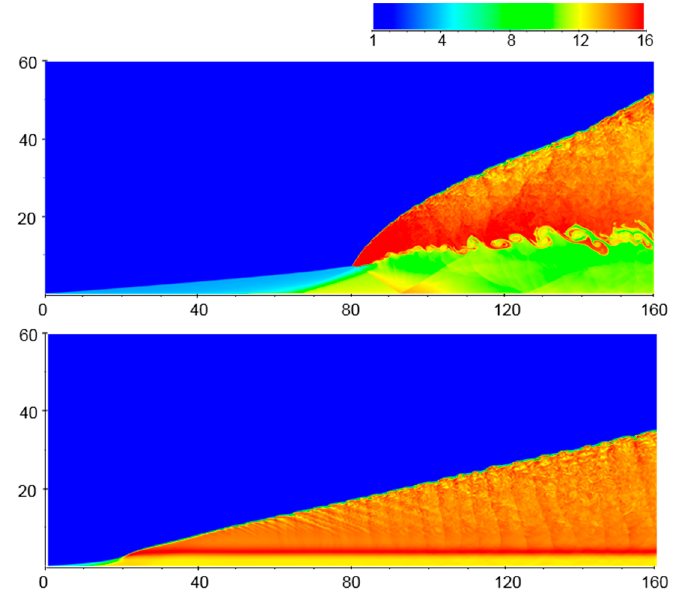
Figure 7. Temperature contours with E a = 35, k = 185.0 and θ = 26 ◦ for M 0 = 10 (upper) and M 0 = 12.5 (lower).